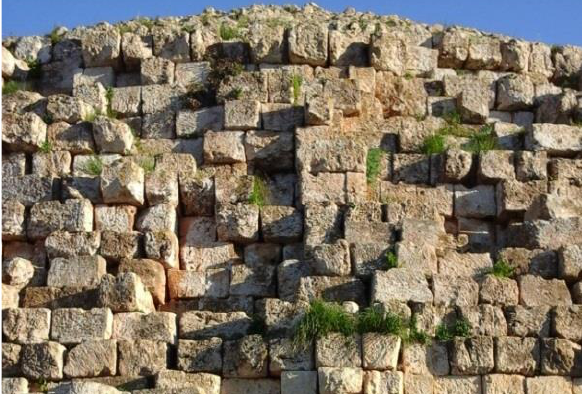
Figure 2. The vulnerability of mausoleum stones under